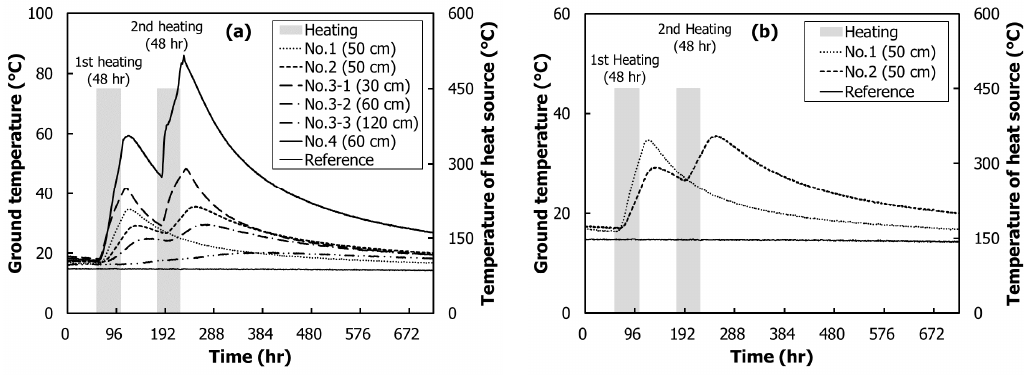
Figure 7. The variation of the ground temperature due to ground heating. ( a ) Overall sensor; ( b ) comparison of the temperature variation due to the installation of the steam discharge hole.